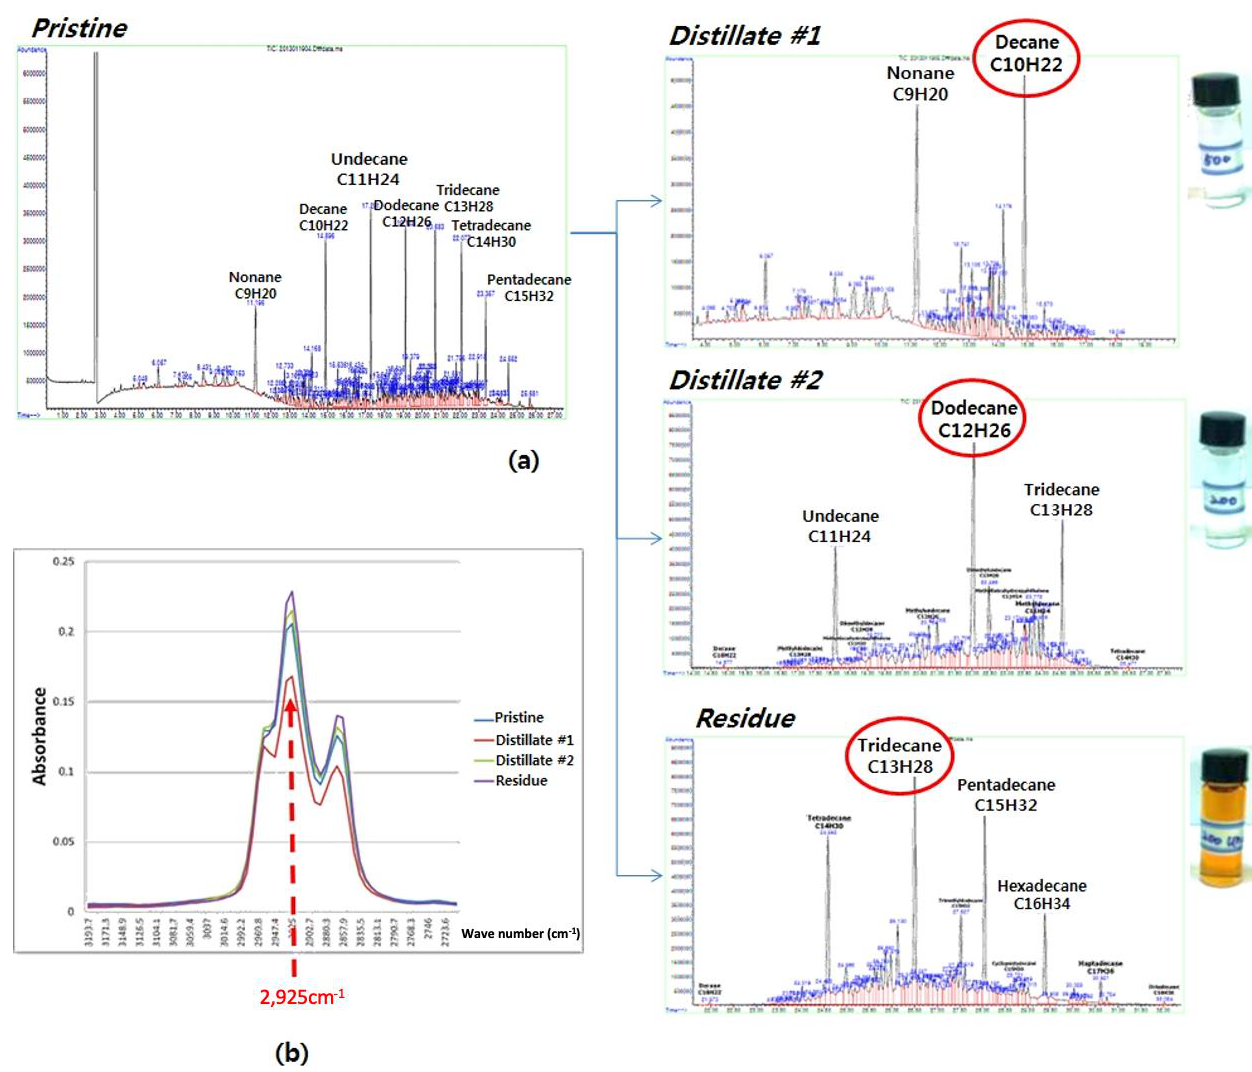
Figure 2. Spectrum of GC-MS ( a ) and FTIR ( b ) for fractionally distilled additives.